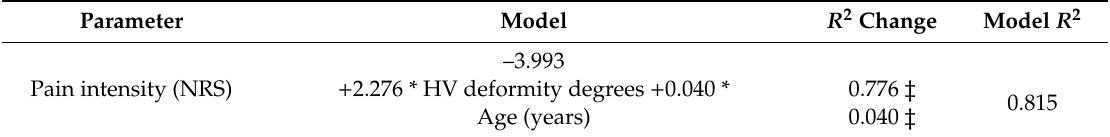
Table 4. Linear regression model for the pain intensity multivariate among HV deformity degrees. Parameter Model R 2 Change Model R 2 Pain intensity Table 3. Linear regression model for the kinesiophobia total score multivariate among HV deformity degrees. Parameter Model R 2 change Model R 2 Kinesiophobia total score (TSK-11) 15.136